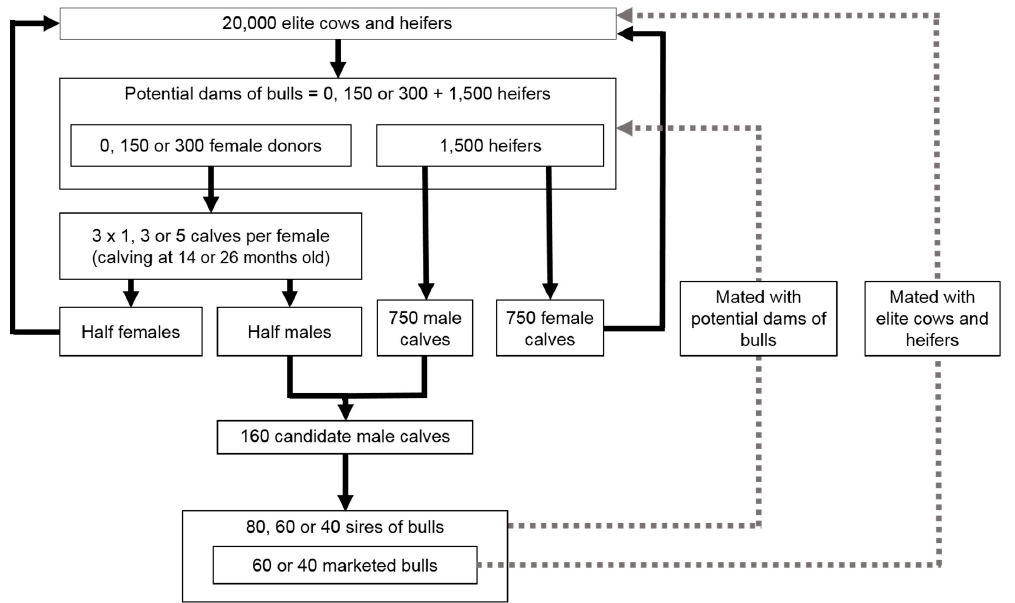
Figure 1. Selection steps in the simulated dairy cattle breeding scheme using embryo transfer.